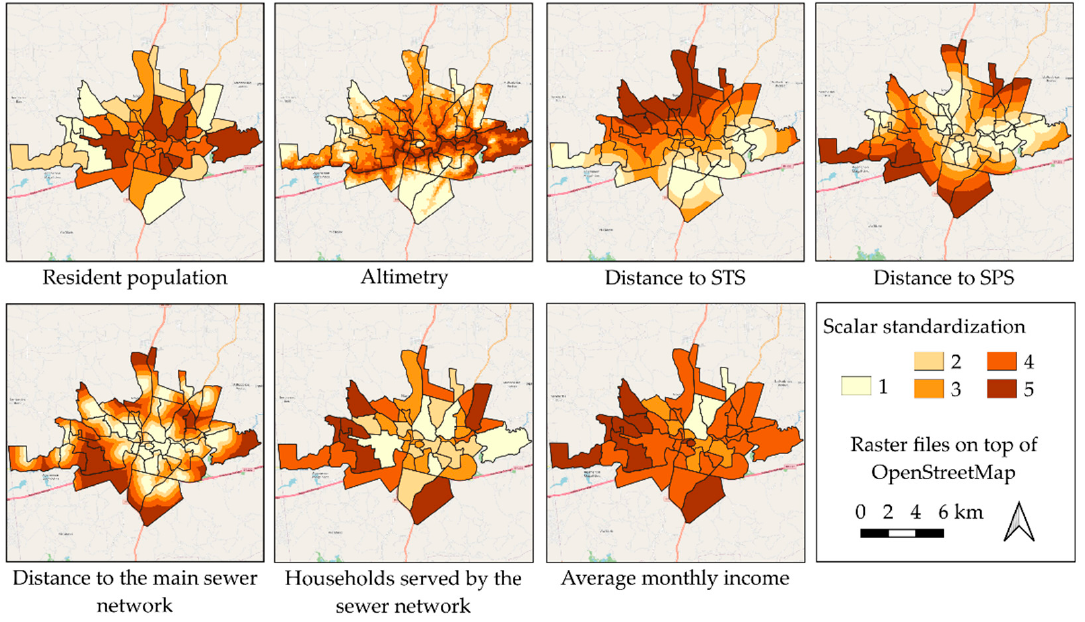
Figure 5. Standardization of criteria to assess the degree of insufficiency of the sanitary sewage network, using a scale from 1 to 5. Table 3. Degree of importance of the AHP method